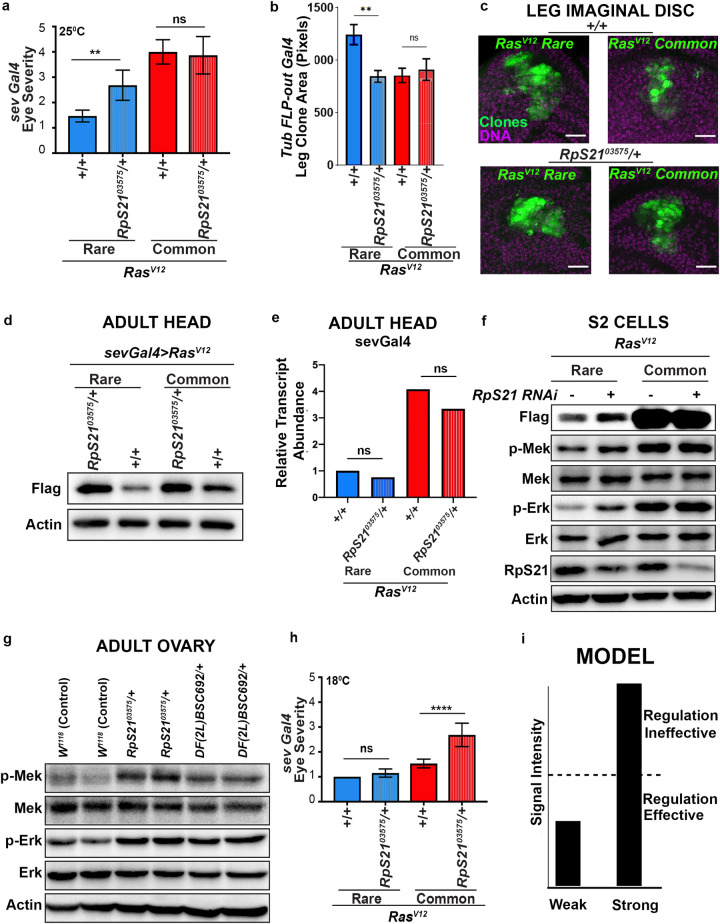
RpS21 negatively regulates Ras/MAPK signaling in a signal strength-specific manner.(a) The mean ± SEM eye severity score of the genotypes from three replicate experiments at 25°C. (b) The mean +/- SEM leg imaginal disc clone size in pixels for each genotype (3 replicate experiments, N = 10–33 total animals. One-way ANOVA test. (c) Images representing the leg imaginal disc Tubulin-Gal4 FLP-out clone sizes generated in the indicated genotype backgrounds. Scale bars = 20 um. (d) Immunoblot detection of transgenic RasV12 (with an anti-FLAG antibody), and actin as a loading control from lysates derived from the heads of flies with the indicated versions of transgenic RasV12 in either the wild-type (+/+) or mutant (RpS2103575/+) RpS21 backgrounds. (e) Quantitative RT-PCR, measured using 2^ΔΔCt, of animals expressing the indicated versions of transgenic RasV12 in either the wild-type (+/+) or mutant (RpS2103575/+) RpS21 backgrounds. Data represent three independent replicates per condition, with 10–40 animals/replicate. One-way ANOVA and Tukey’s multiple comparisons test. (f) Immunoblot detection of transgenic RasV12 (with an anti-FLAG antibody), phosphorylated (p-) and total Mek and/or Erk, RpS21, and actin as a loading control from lysates derived from S2 cells stably transduced with expression vectors expressing the indicated RasV12 transgenes in the absence (-) and presence (+) of RpS21 RNAi. (g) Immunoblot detection of indicated proteins derived from lysates of the adult ovaries of either wild-type (+/+) or mutant (RpS2103575/+) flies. (h) The mean ± SEM eye severity score of the genotypes from three replicate experiments at 18°C. Tukey’s multiple comparisons test was used for statistical comparisons in a and e. ****p<0.0001. **p<0.01. n.s., not significant. (i) Model depicting how a signal intensity modifier such as RpS21 may be ineffective above a specific signaling intensity threshold (dotted line).